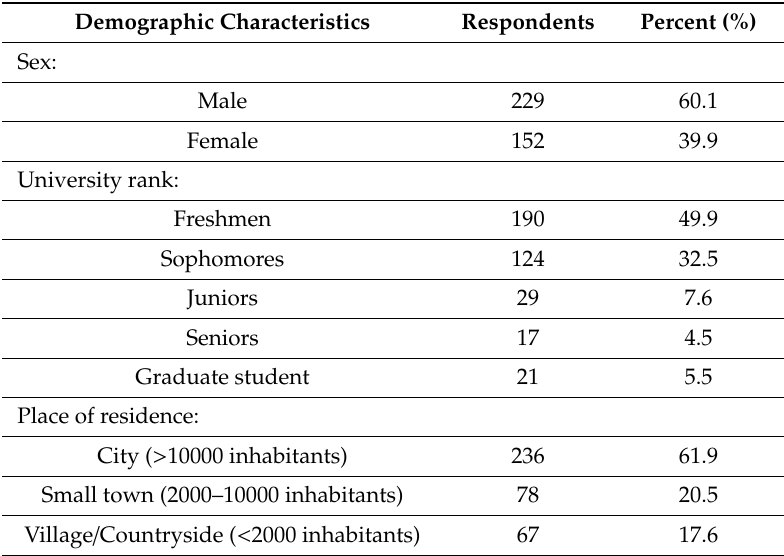
Table 3. Demographics of the study participants (n =